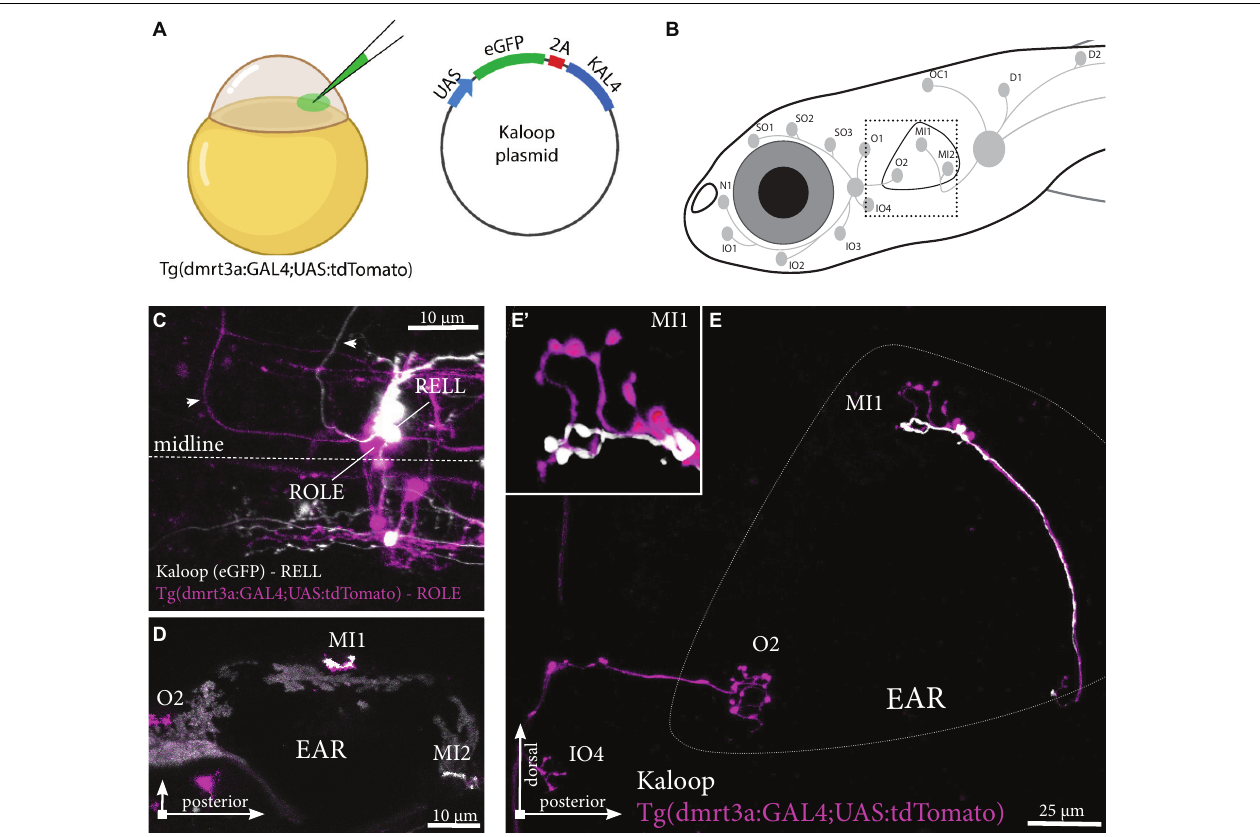
FIGURE 6 | Tg( dmrt3a :GAL4;UAS:tdTomato) injected with Kaloop plasmid reveal multiple inhibitory efferent cells innervating a single neuromast. (A) One-cell stage embryos of Tg( dmrt3a :GAL4;UAS:tdTomato) were injected with Kaloop plasmid to generate larvae with sparsely labeled tdTomato and eGFP inhibitory efferents. (B) Schematic overview of the area shown in (E) . (C–D) Confocal images showing the view of sparsely labeled inhibitory efferent cells in their nuclei. A ROLE (tdTomato-positive; magenta) and a RELL (eGFP-positive; white) cell were identified (C) and their projections traced across the lateral line (D) dorsal view and